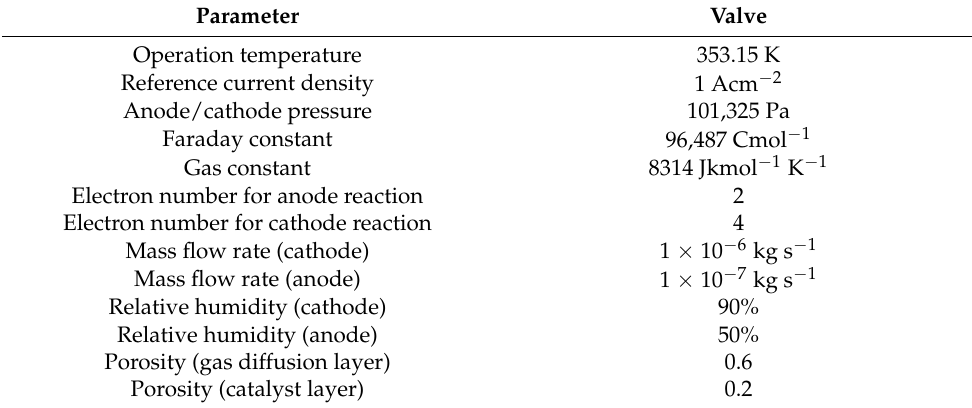
Table 2. Operating